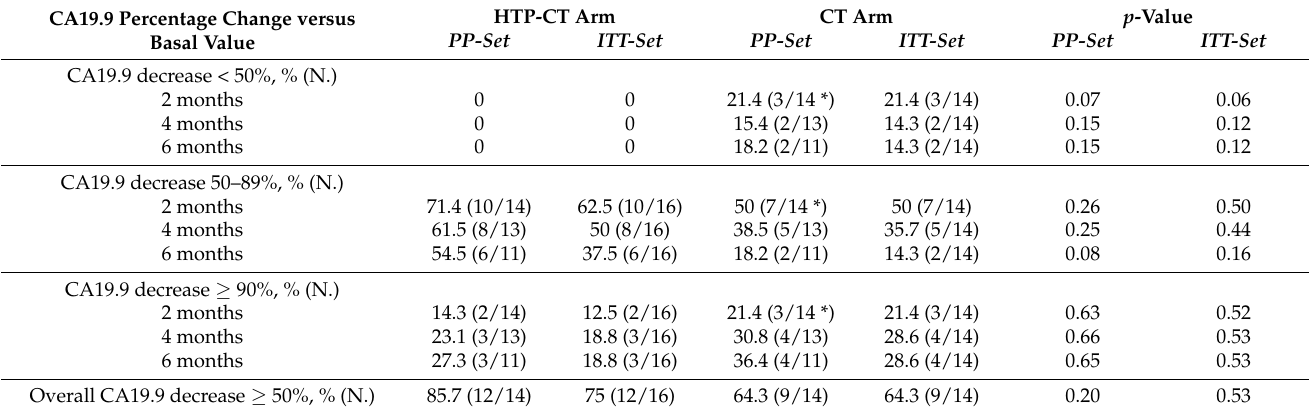
Table 3. Rates of <50% (non-biochemical responders), 50–89% (minor biochemical responders) and ≥ 90% (major biochemical responders) decrease of CA19.9 serum levels (UI/mL) at 2-, 4- and 6-months follow-up. Only patients with basal upper limit of laboratory normal for CA19.9 were considered (HTP-CT arm: n = 16; CT arm: n = 14). CA19.9 Percentage Change versus Basal